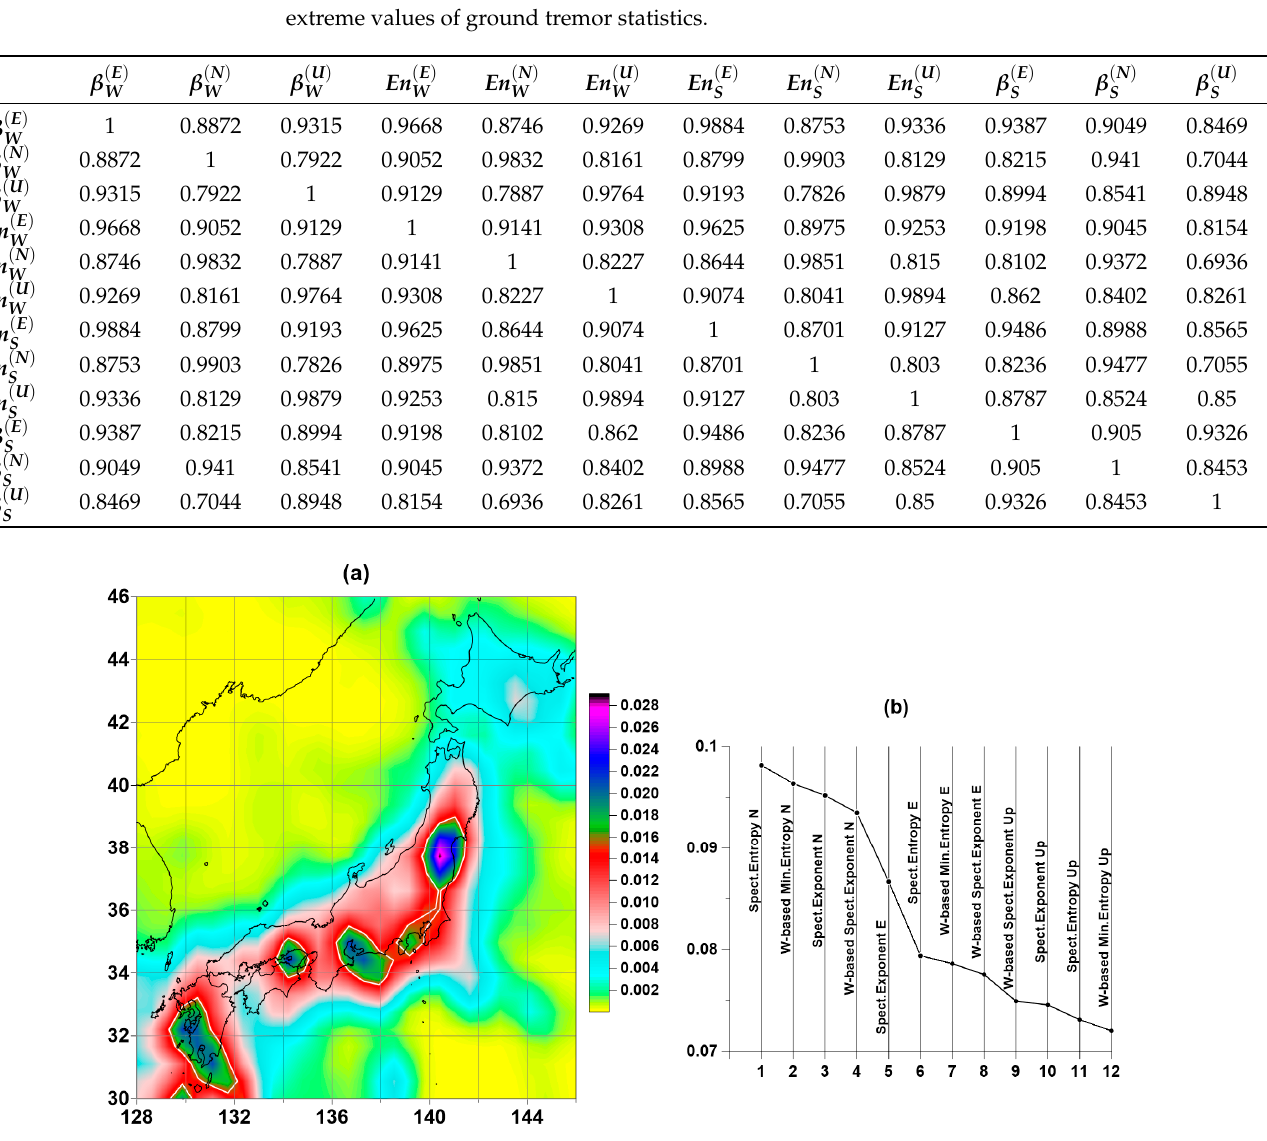
Figure 5. ( a )—weighted average map of distribution of extreme values of four properties of the Earth’s surface tremors for three displacement components E, N, and Up, white contour lines extract anomalous regions of Earth’s tremor as 98% quantile of probability density values; ( b )—values of the squares of the main eigenvector components of the correlation matrix between the distribution maps of extreme values of four daily tremor properties of the Earth’s surface for three displacement components E, N, and Up on a regular 30 × 30 grid of nodes, sorted in descending order.